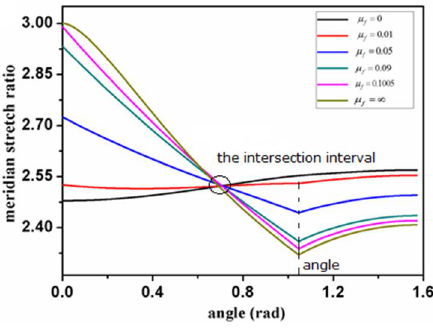
 with angle  under different